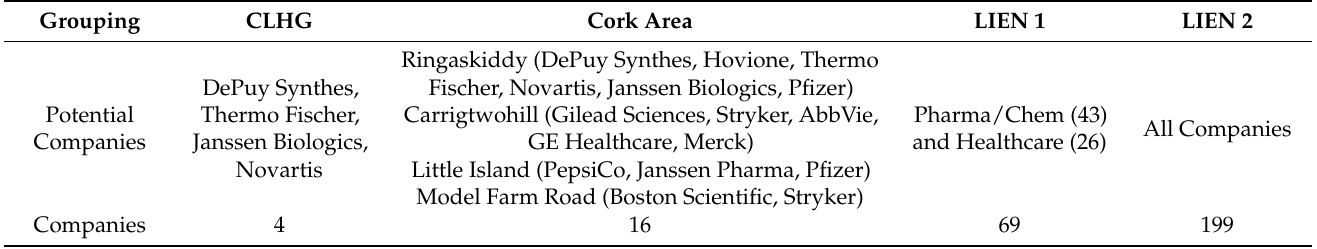
Table 7. Overview of four potential groupings this concept could be implemented in and scaled to within the Irish industrial